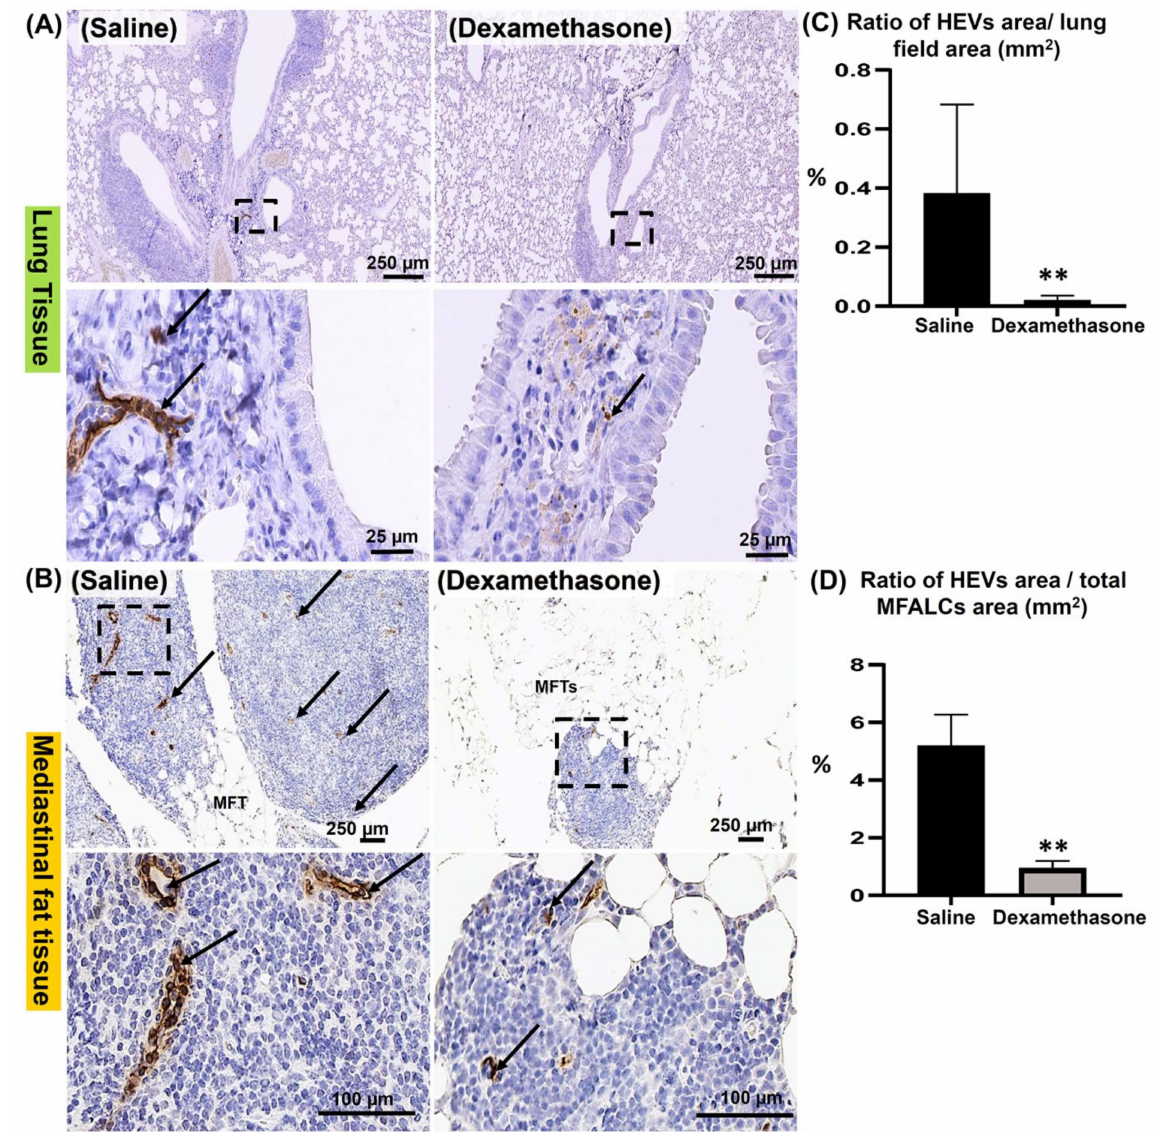
Figure 4. Analysis of the effect of dexamethasone on the degree of the development of HEVs in the lungs and mediastinal fat associated-lymphoid clusters (MFALCs) in female Lpr mice. ( A , B ) Repre- sentative images of the immunohistochemical-stained lung ( A ) and mediastinal fat tissue sections ( B ) stained with anti-PNAd antibody in both the saline and dexamethasone groups. Notice PNAd + HEVs (arrows). ( C , D ) Representative graphs showing the percentage of the relative area ratio of PNAd + HEVs in the lungs ( C ) and MFALCs ( D ). A highly significant value (**) was observed between saline and dexamethasone groups ( p values < 0.01), where n = 5 in each experimental group. Analysis was conducted using the Mann–Whitney U test. Data are presented as mean values ±